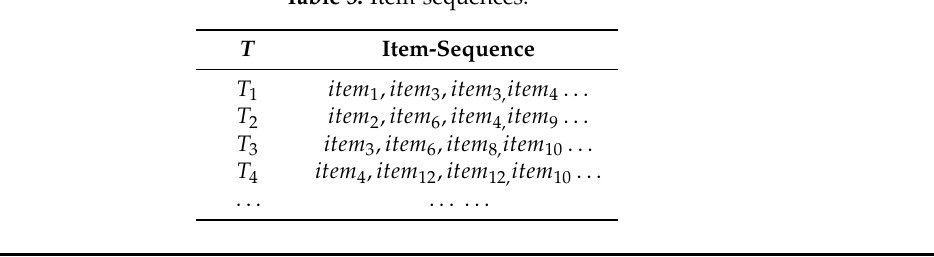
Table 5. Item-sequences.